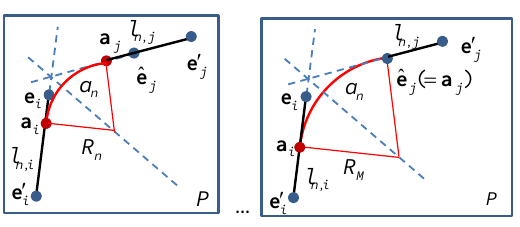
Figure.6 Complementing axes of the junction